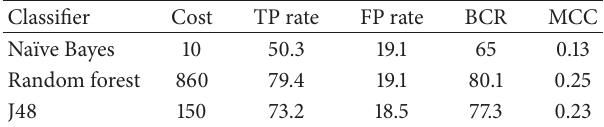
Table 1: Comparison of sensitivity, specificity, accuracy, and bal- anced classification rates and Matthews correlation coefficient for each of the classifiers used in the present